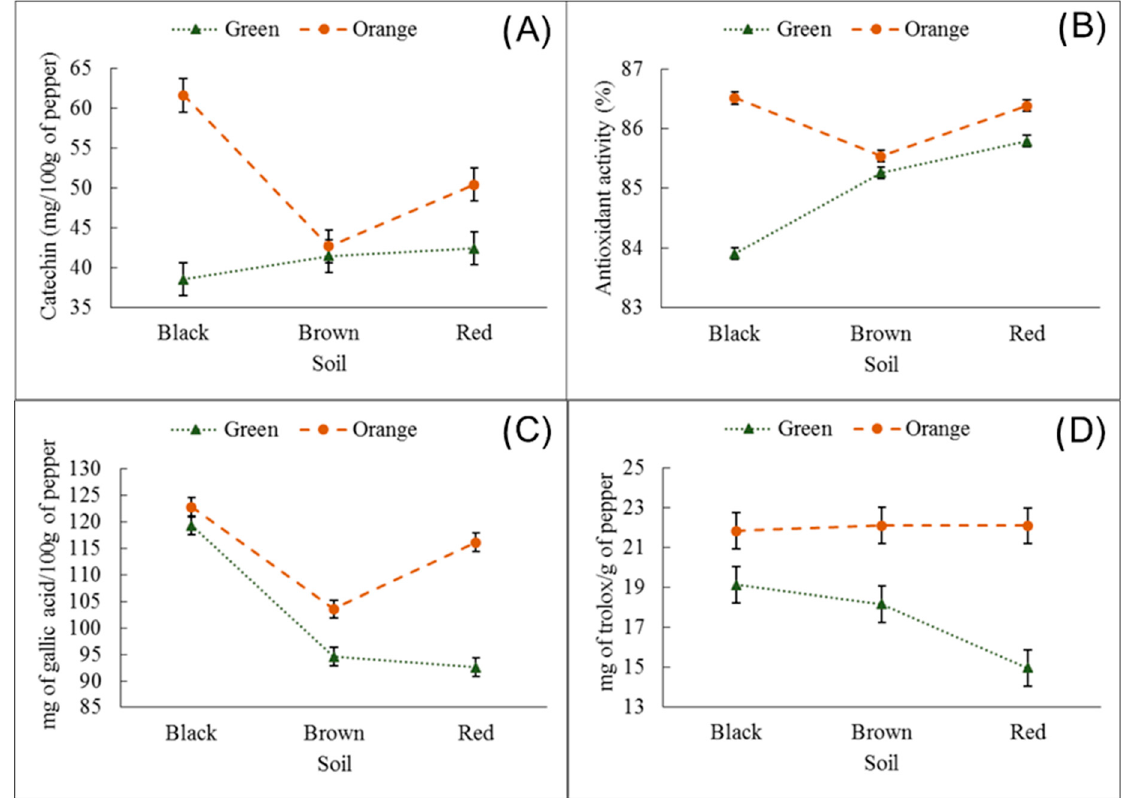
Figure 2. Interaction graphs of the effect of the factors degree of maturity and soil on different response variables: ( A ) concentration of catechin, ( B ) antioxidant activity by DPPH, ( C ) concentration of total polyphenols and ( D ) antioxidant activity by ABTS. The error bars on the figure represent the standard error ( p ≤ 0.05) of the analysis of interaction of the factors degree of maturity and soil.